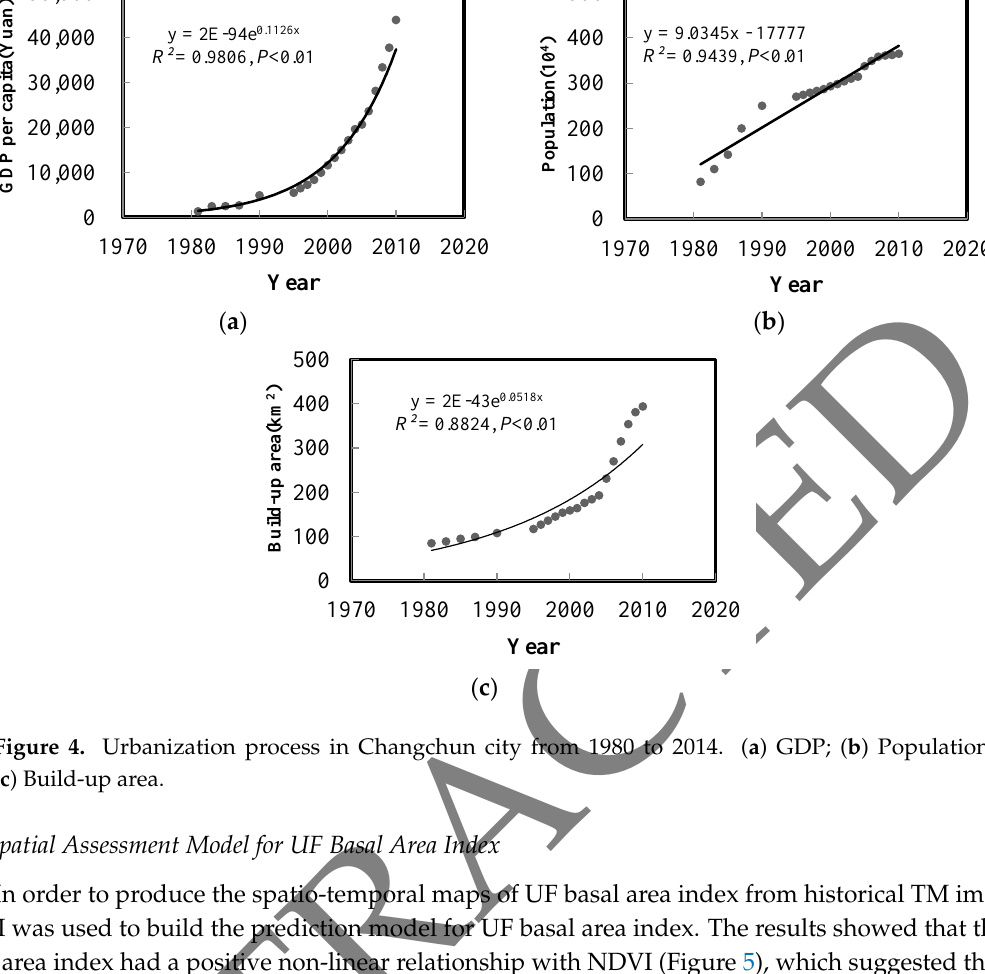
Figure 4. Urbanization process in Changchun city from 1980 to 2014. ( a ) GDP; ( b ) Population; ( c ) Build-up area.